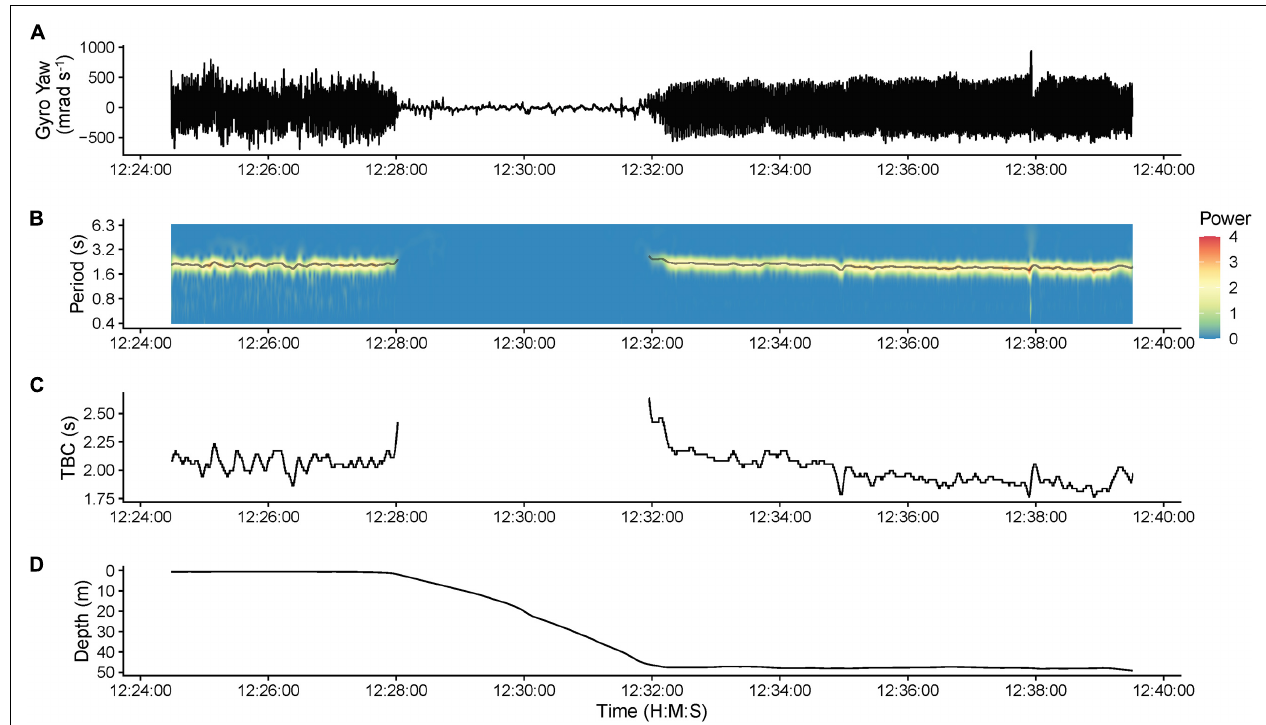
FIGURE 3 | Example data from shark s292w (193 cm fork length, female) illustrating the determination of tailbeat cycle length and gliding behavior (no tailbeats) using continuous wavelet transformation of gyroscope data. (A) Raw gyroscope yaw (lateral angular velocity) data. (B) The corresponding time-frequency wavelet power spectrum, determined through continuous wavelet transformation, showing the different oscillation periods present in the gyroscope yaw data. The gray line overlayed on the spectrum is the output of the ridge determination procedure and indicates the period of the ridge with the highest power value (dominant oscillation signal) at each time point. (C) The tailbeat cycle (TBC) extracted from the ridge determination procedure. (D) The depth profile of the shark. Gliding behavior (no tailbeat) was determined when no ridge was identified. Gliding is evident with a lack of periodicity in the gyroscope data during a descent from the surface to ∼ 50 m depth, after which tailbeats